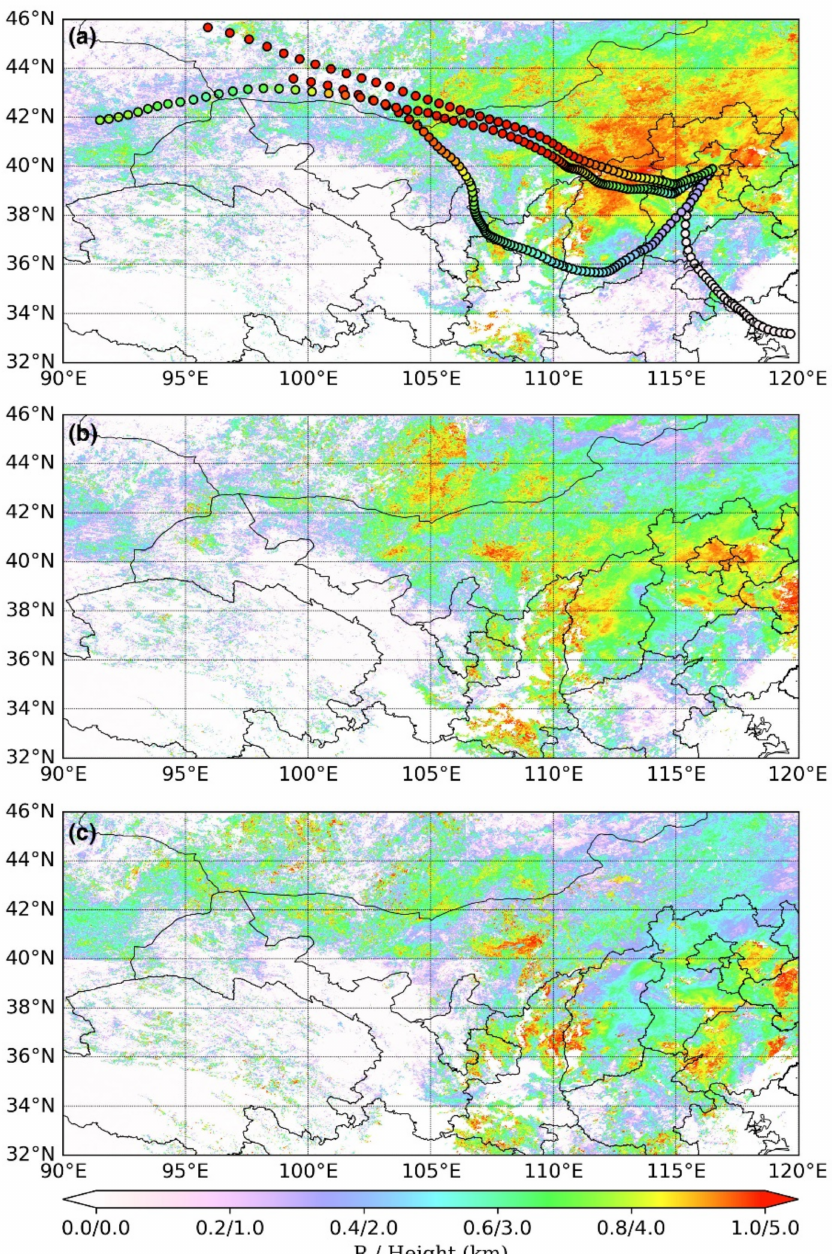
Figure 10. Spatial distribution of the correlation coefficients between observation site and each grid’s daily AOD at lag ( a ) 0 day, ( b ) 1 day, and ( c ) 2 day from 24 September to 3 October, 2019. Seventy-two hour backward trajectories arriving at the observation site at 10:00 LT on 1 October 2019 at 500 m, 1500 m, 2500 m, and 3500 m overlaid on ( a